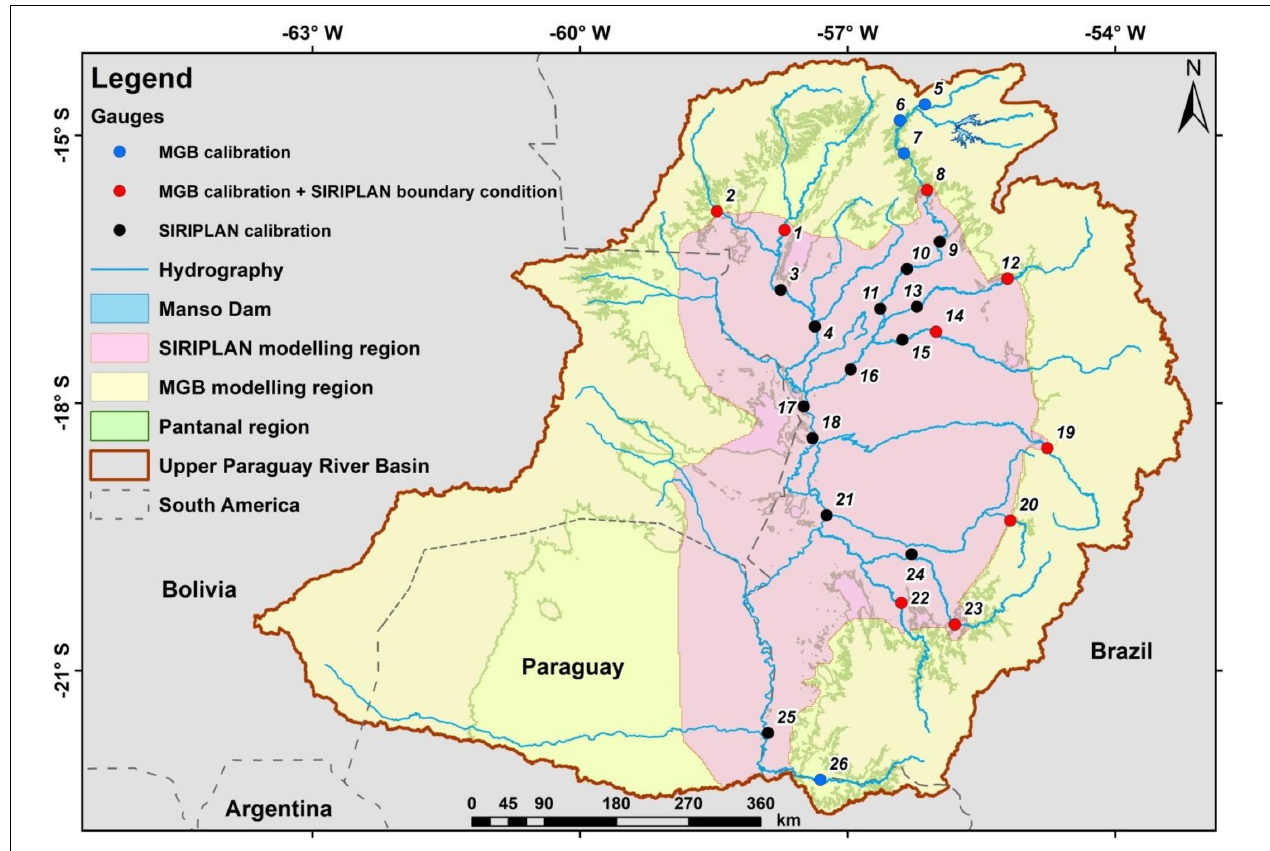
FIGURE 2 | Modeling sub-regions of the Upper Paraguay basin (yellow = MGB model; pink = SIRIPLAN model) and gauges used for calibration (red points are boundary condition locations where streamflow time series calculated with MGB were transferred as input data to